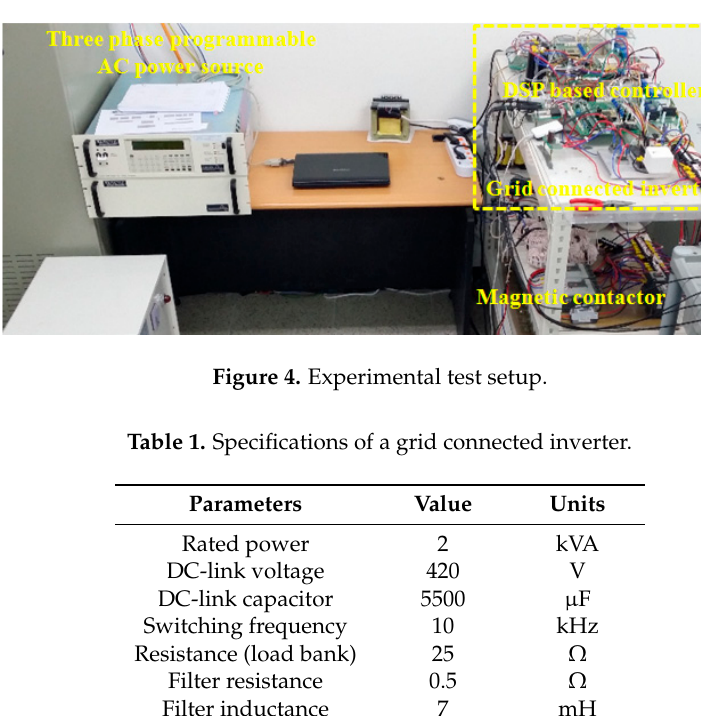
Figure 3. Configuration of the overall system.